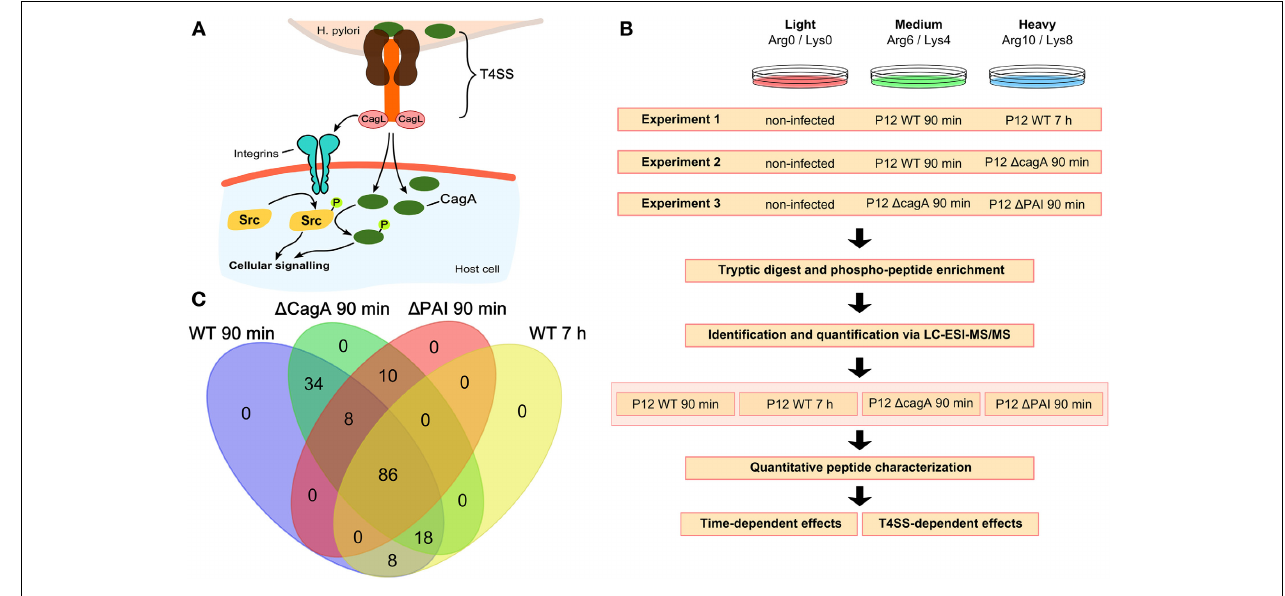
FIGURE 1 | Experimental setup and analysis workflow. (A) The H. pylori T4SS interacts with the host cell either directly, e.g., via integrins, or via translocation of the virulence factor CagA, resulting in phosphorylation of Src followed by phosphorylation of CagA. (B) Three different experimental set-ups each consisting of three different SILAC labeling conditions were used. For each set-up, four biological replicates were analyzed. All